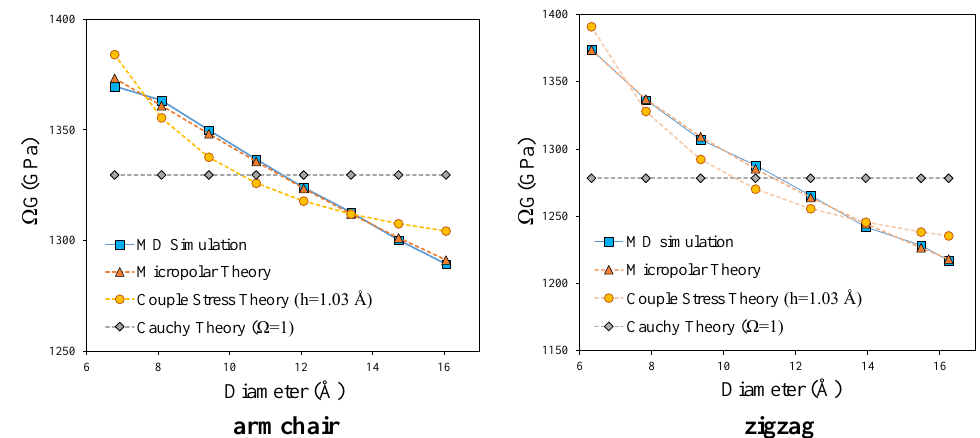
Figure 5. Comparison of apparent shear modulus from micropolar, couple stress and Cauchy models with MD